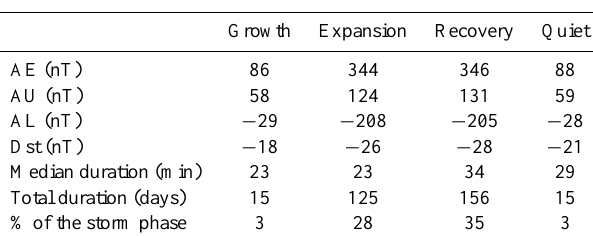
Table 4. Median values of substorm phases during storm main phases.